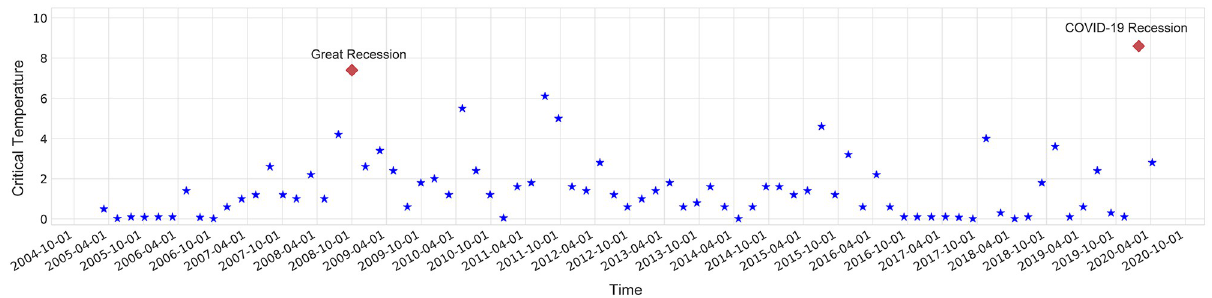
Fig 6. Critical temperature for Great Recession and COVID-19 Recession. The stronger correlation of stocks results in a more serious crisis and a higher thermal fluctuation needed to destroy this highly correlated structure of stocks.